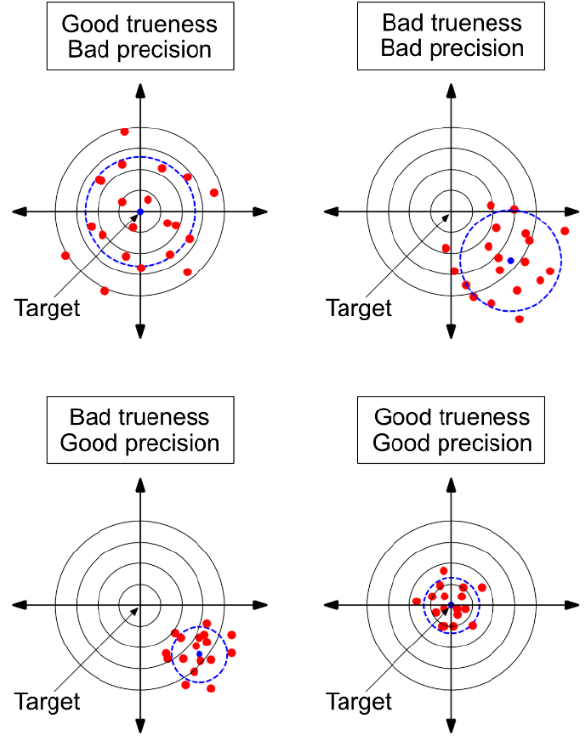
Figure 1. Bull’s eye for illustrating the accuracy (adapted from ISO 5725-1 [20] with permission from the German Institute for Standardisation (DIN)).